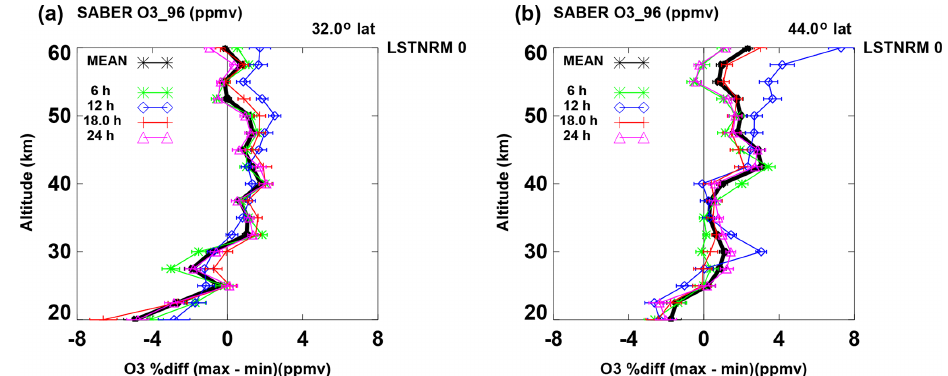
Figure A1. As in Fig. 7, ozone responses at 32 ◦ (a) and 44 ◦ from 20 to 60km. Values are responses at solar max minus responses at solar min (%/100sfu). Black asterisks denote our responses based on zonal means that are averages over both longitude and local time. Green asterisks denote our responses of zonal means at 6LST, blue diamonds denote our responses of zonal means at 12LST, red plusses denote our responses of zonal means at 18LST, and magenta triangles denote our responses of zonal means at 24LST, based on SABER data.